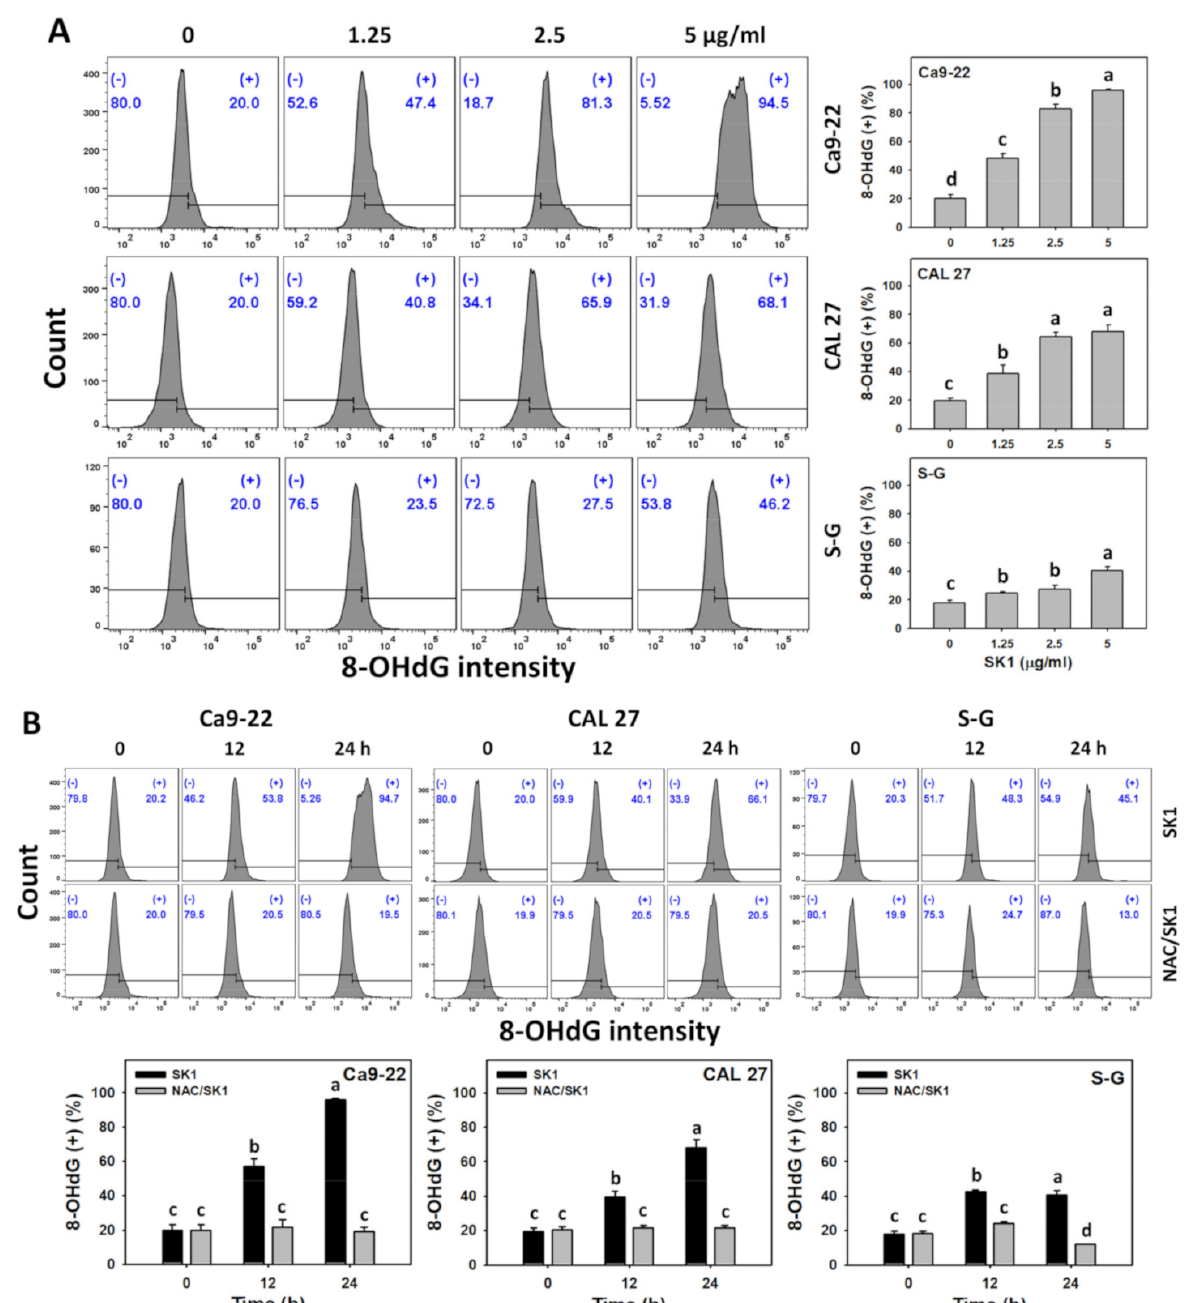
Figure 10. DNA damage effects (8-OHdG) of SK1. ( A ) 8-OHdG assays of SK1. Non-malignant (S–G) and oral cancer (Ca9-22 and CAL 27) cells were treated with SK1 (0 (0.1% DMSO in medium), 1.25, 2.5, and 5 µ g/mL) for 24 h. ( B ) 8-OHdG assays of NAC/SK1. NAC/SK1 indicated that cells were pretreated with NAC and posttreated with SK1 5 µ g/mL for 0, 12, and 24 h. (+) inserted at the histogram is counted for the percentage of 8-OHdG (+)(%). Data, mean ± SD ( n = 3).